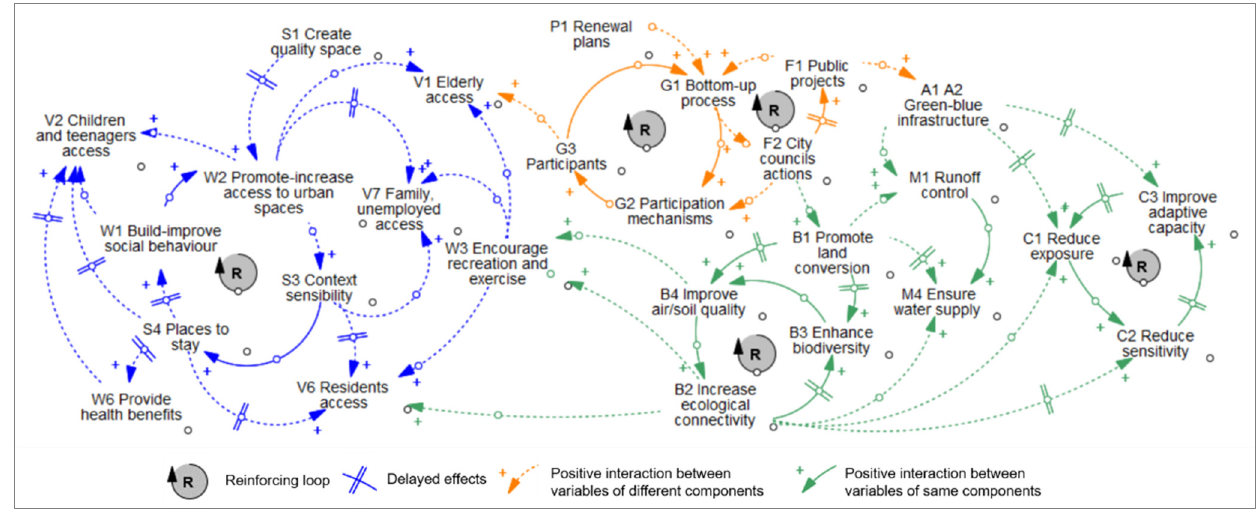
Figure 3. The CLD combining variables from social, political, and environmental dimensions. Note: Only those variables and related interactions identified in at least half of the case studies when addressing the triple-loop analysis (that is, obtaining 50% of ticks in Tables 2–4) have been consid- ered for the CLD analysis. Components are grouped by the same colours used in Figure 1: blue (social dimension), orange (politic dimension), and green (environmental dimension).